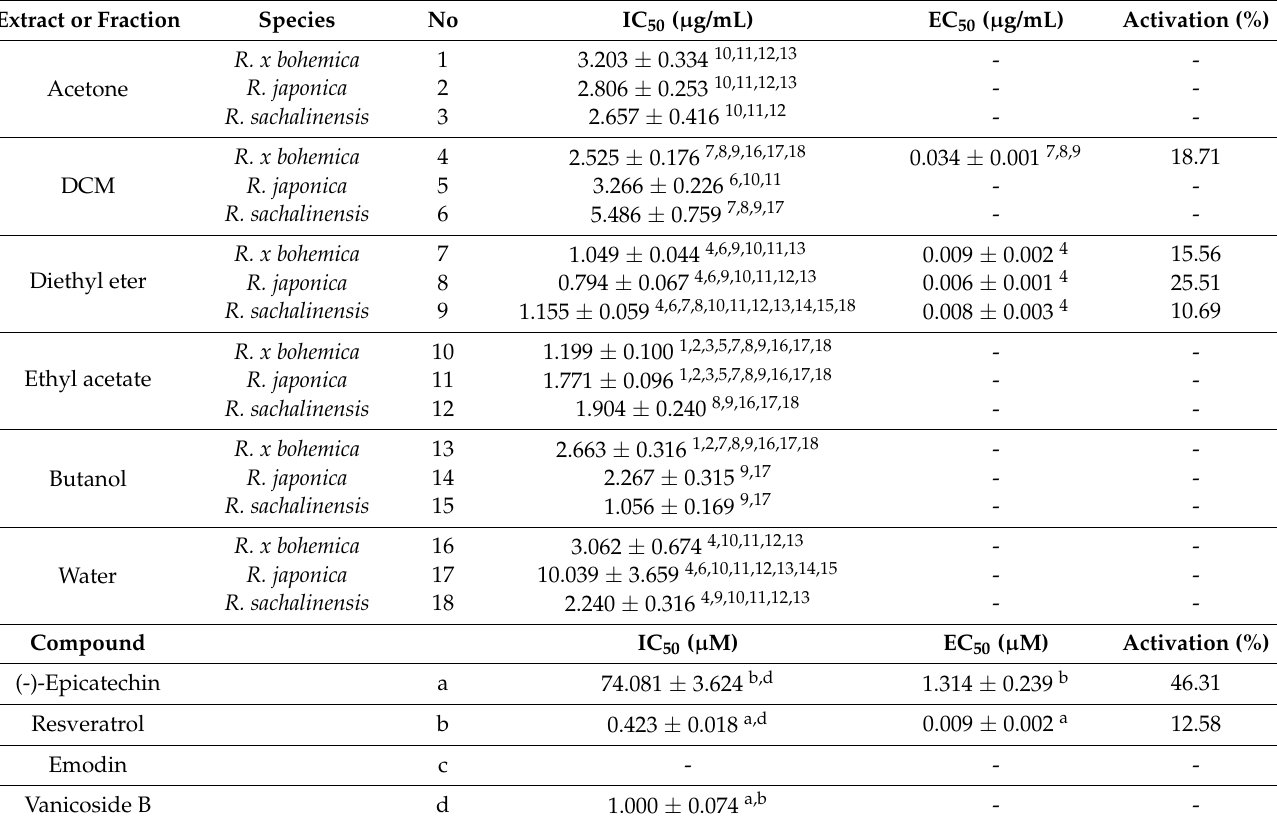
Table 1. Half-maximal inhibitory concentration (IC 50 ), half-maximal effective concentration (EC 50 ), and the percentage of activation of individual fractions obtained for extracts originating from the rhizomes of Reynoutria sp. Species, extracts fractions at selected solvents, and analyzed polyphenols. The means were calculated from 4–8 replicates; after ‘ ± ’, a standard error is given. Numbers/letters in superscript indicate significant differences between extracts/fractions/compounds with a given number obtained with ANOVA with post-hoc Tukey